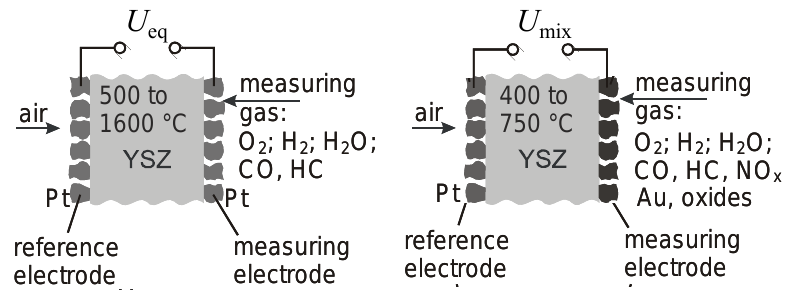
measuring electrodereference